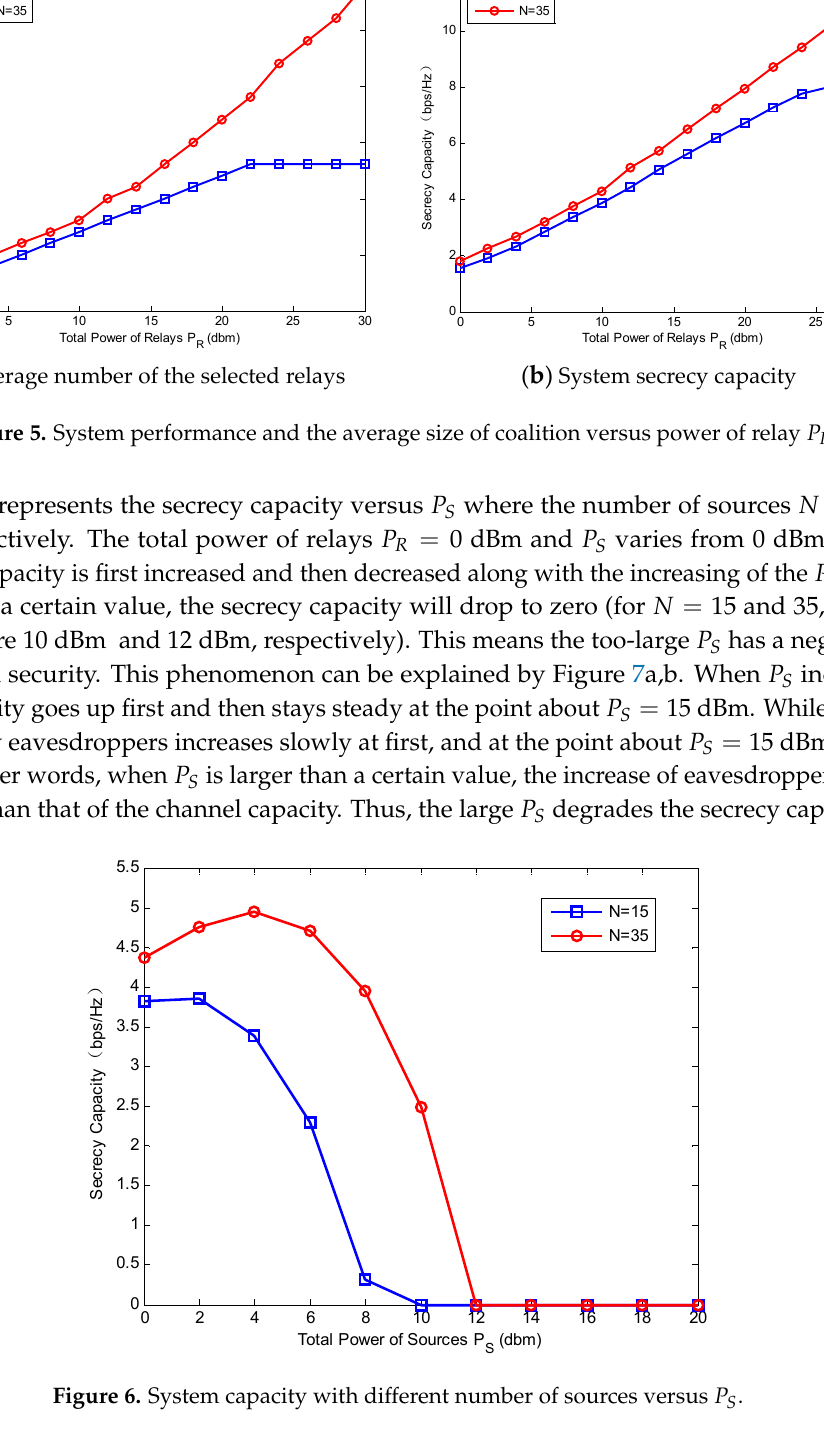
Figure 6. System capacity with different number of sources versus P S